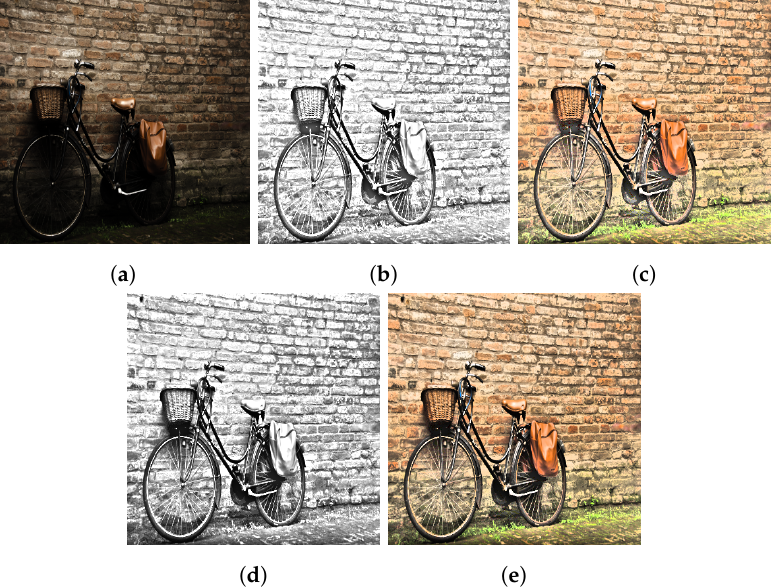
Figure 6. Comparison of SVD-CSC and CSC methods without SVD: ( a ) Original test image; ( b ) Reflectance using CSC general dictionary; ( c ) Image enhancement using CSC general dictionary; ( d ) Reflectance using SVD-CSC general dictionary; ( e ) Image enhancement using SVD-CSC general